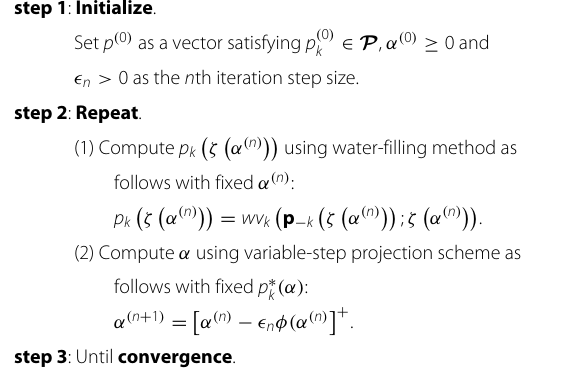
Table 1 Proposed iterative AO